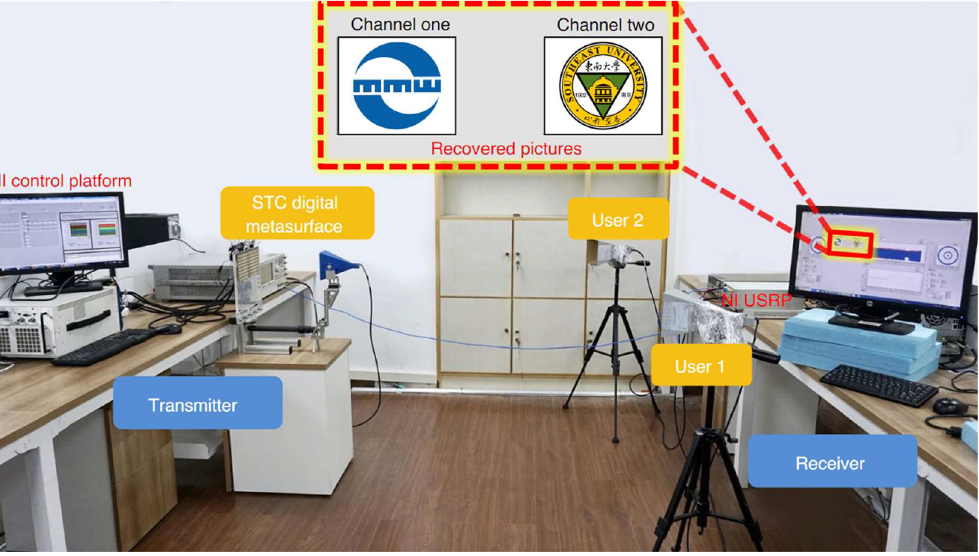
Figure 4: The wireless information transmission with digital metasurfaces [71]. Reprinted from [71], with the permission of Springer Nature Publishing. © 2021, The Author(s), under exclusive license to Springer Nature